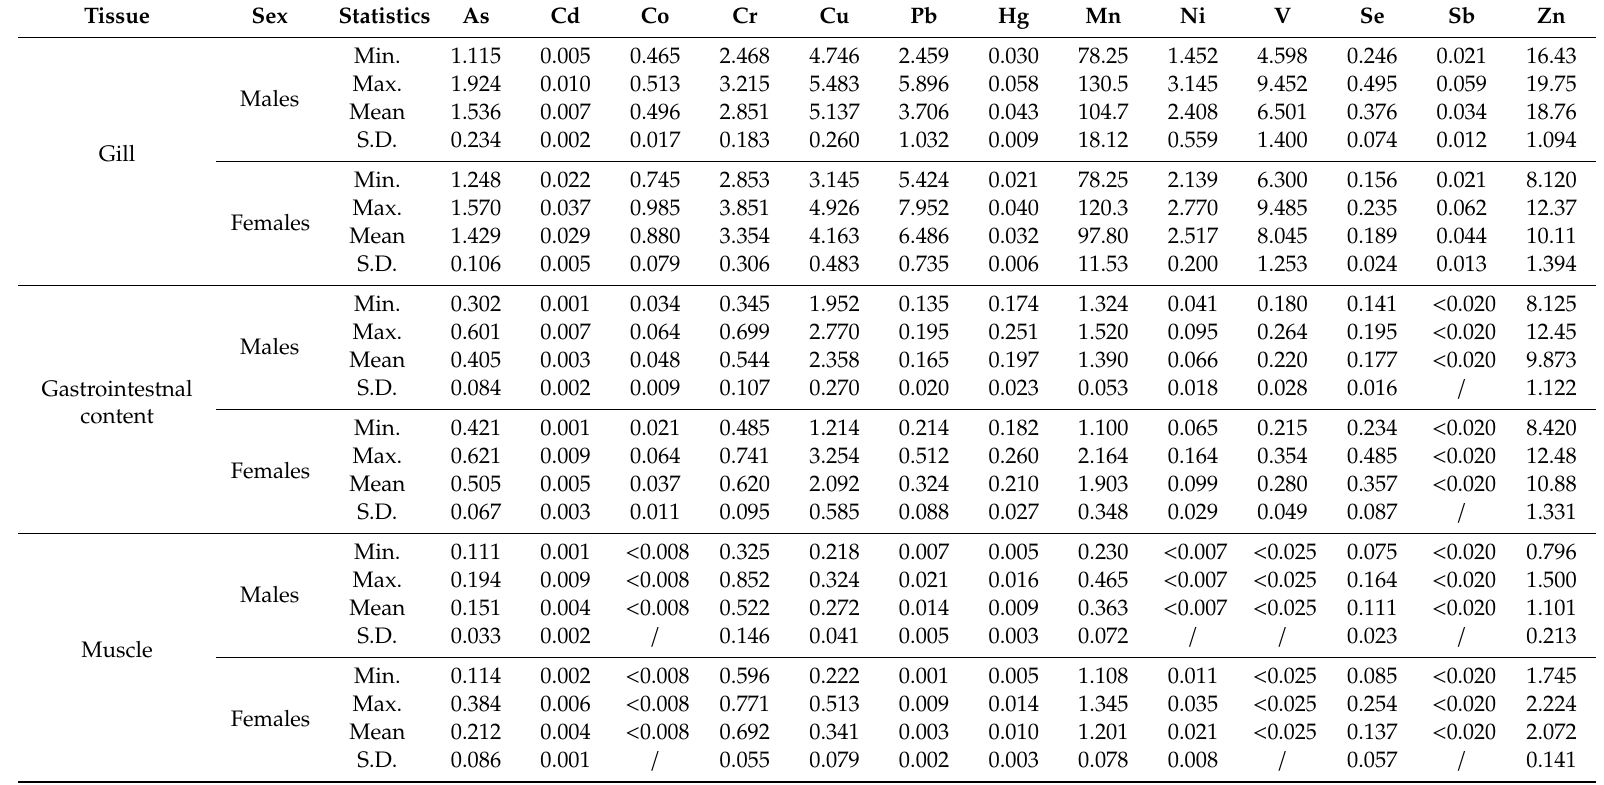
Table 1. Descriptive statistics of metals and metalloids (mg / kg ww) in Merluccius merluccius . Tissue